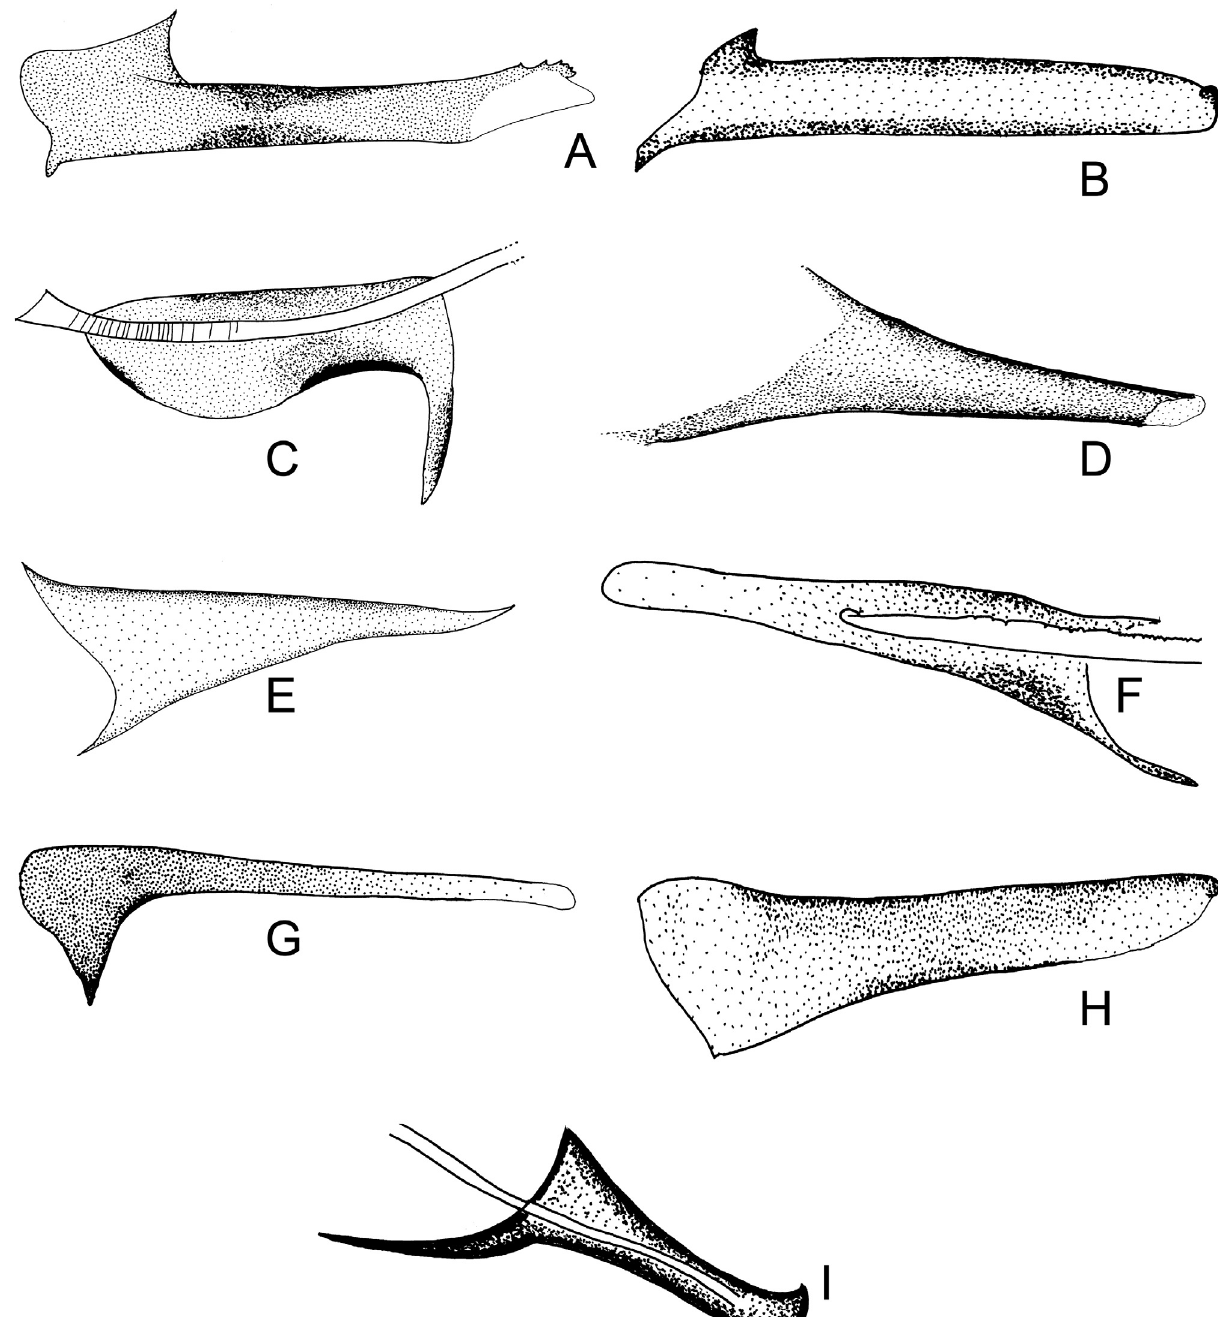
Figure 28. Parameral sheath of Phlebotominae. (A) With a transparent inferior top: Phlebotomus perfiliewi ; (B) rounded with a knob at the top: Idiophlebotomus nicolegerae ; (C) wide and short: Chinius eunicegalatiae ; (D) with transparent top: Phlebotomus ( Euphlebotomus ) barguesae ; (E) pointed: Phlebotomus ( Paraphlebotomus ) chabaudi ; (F) rounded at the top: Sergentomyia ( Vattieromyia ) anka ; (G) drumstick- like: Phlebotomus ( Larroussius ) major ; (H) finger-like: Phlebotomus ( Madaphlebotomus ) vaomalalae ; (I) with hooked top: Phlebotomus ( Paraphlebotomus ) mongolensis